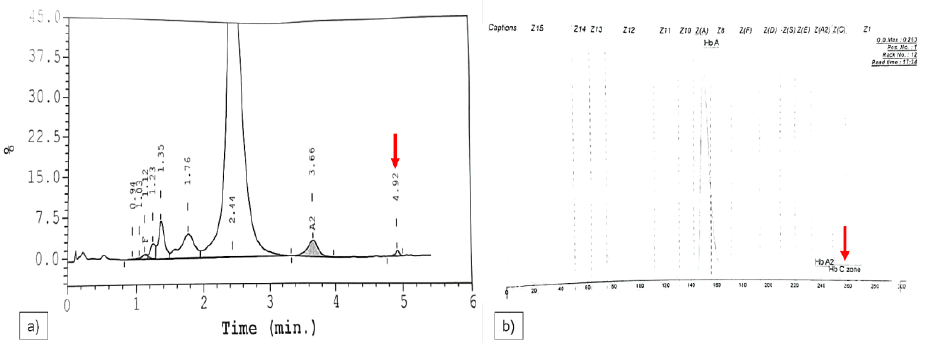
Figure 3. ( a , b ) A representative result of Hb Constant Spring by HPLC and CE analyses. The red arrow represents the Hb Constant Spring peak and zone in HPLC and CE respectively Patients with Hb Quong Sze showed normal haematological parameters except for MCV and MCH, which were slightly lower compared with the normal range. Similar findings were also published; however, most of the studied population had mild to